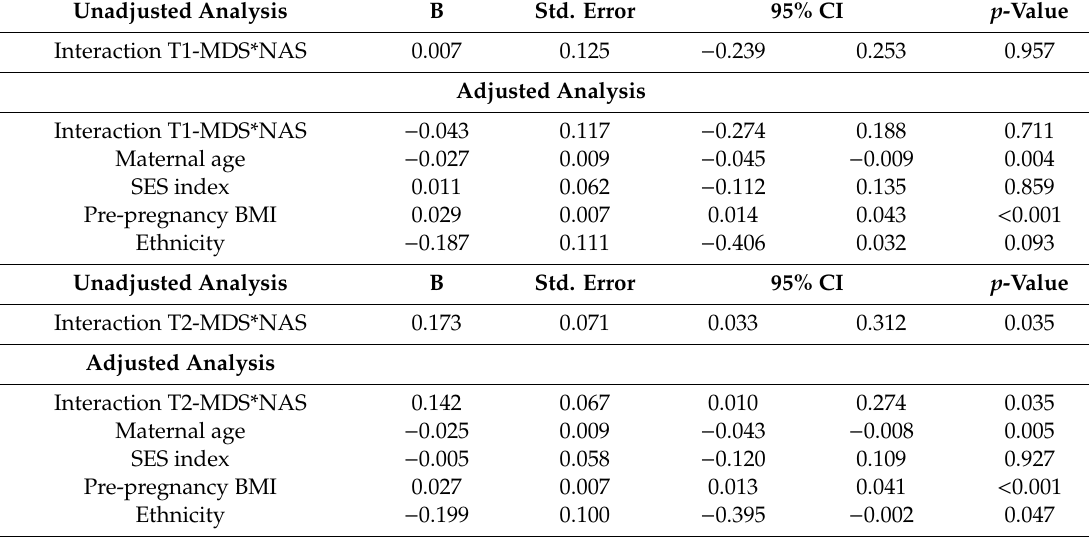
Table 4. Interaction e ff ects of the maternal MDS*NAS in early and mid-pregnancy on the third trimester